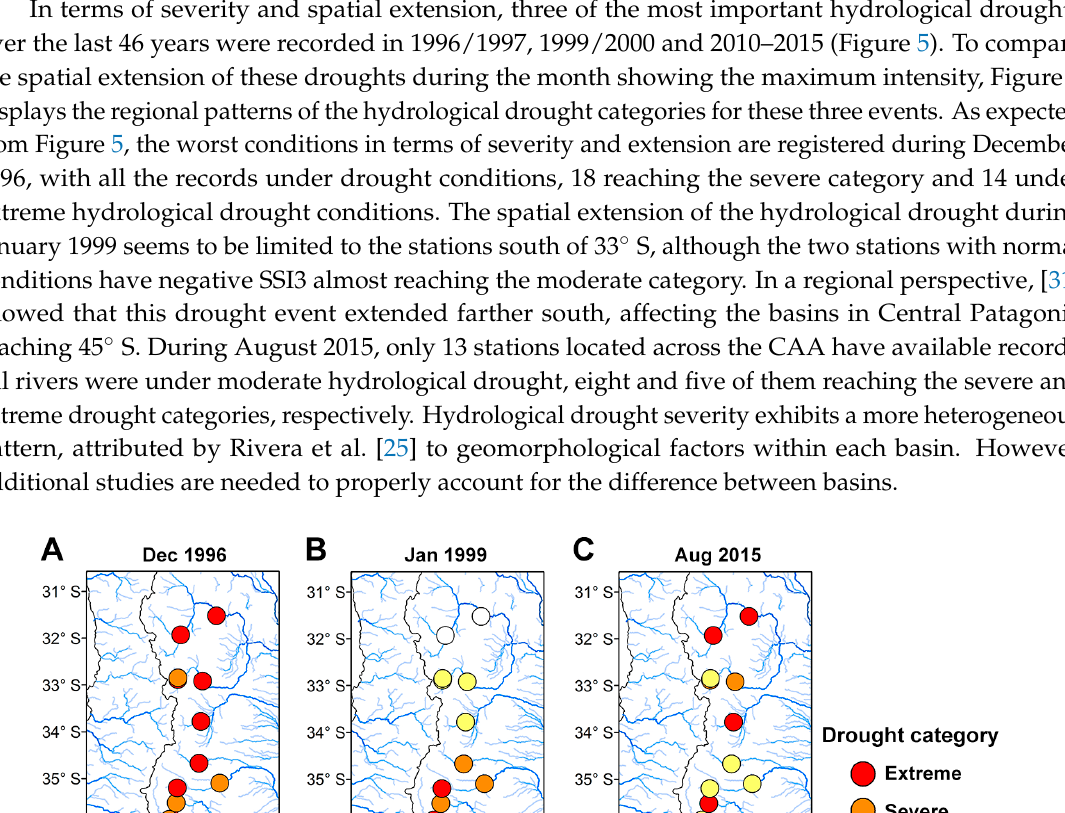
Figure 5. Temporal evolution of the percentage of stations in the Central Andes of Argentina and North Patagonia with hydrological droughts during 1971–2016. Yellow, orange, and red colors indicate moderate, severe, and extreme drought conditions, respectively.